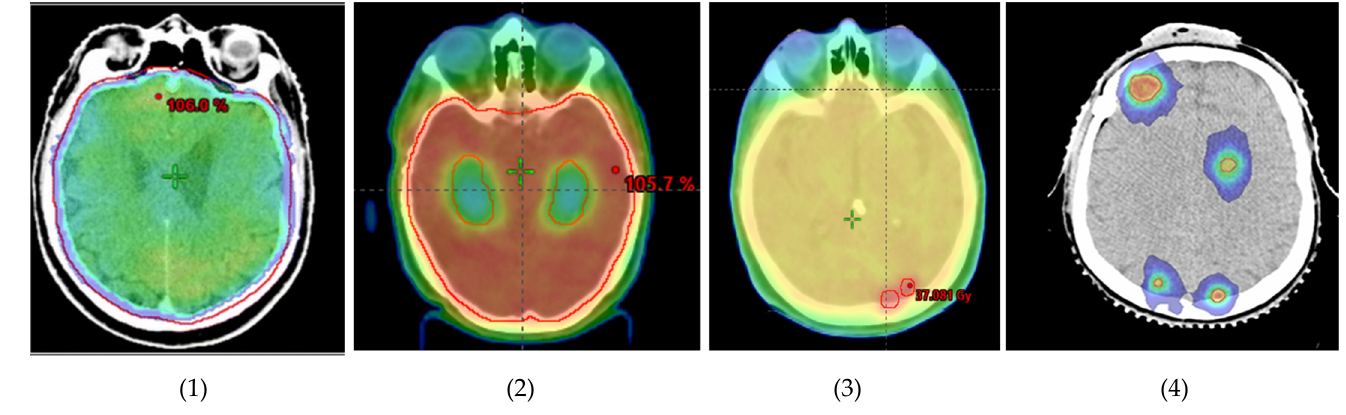
Figure 1. Evolution of brain radiotherapy (from left to right): (1) WBRT; (2) HA-WBRT; (3) WBRT + SIB; (4) multiple-site